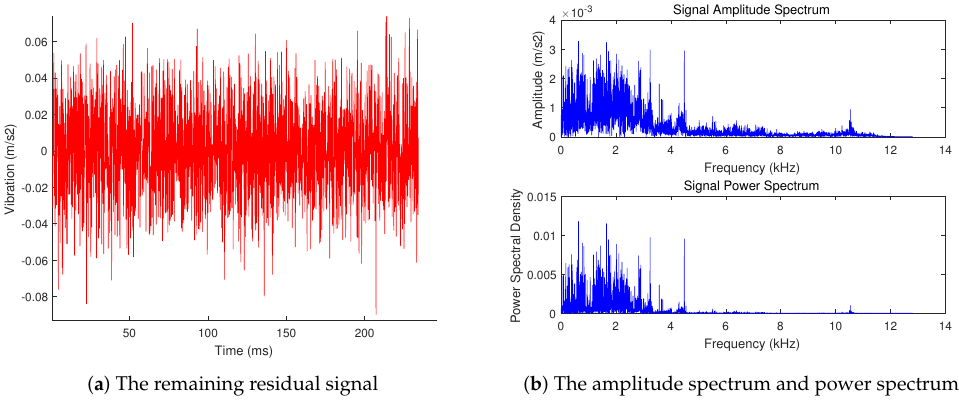
Figure 8. The remaining residual signal and the amplitude spectrum and power spectrum.